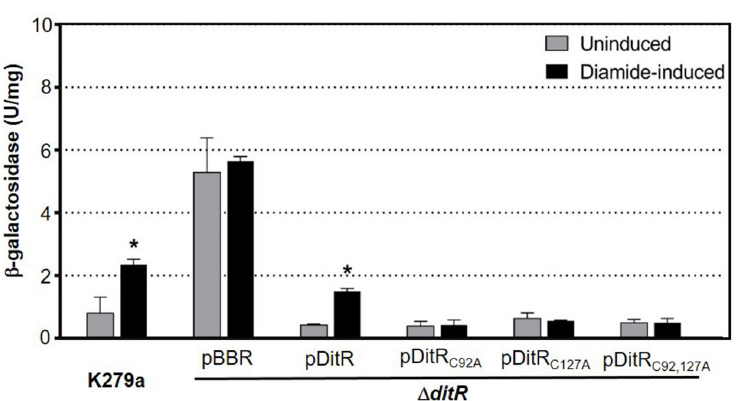
Fig 5. mfsBC promoter activity in S . maltophilia strains. The plasmid pP mfsBC -lacZ containing mfsBC promoter- lacZ fusion was introduced into S . maltophilia K279a and Δ ditR mutant, which harbored the pBBR1MCS vector ( Δ ditR / pBBR), pDitR ( Δ ditR /pDitR), pDitR C92A ( Δ ditR /pDitR C92A ), pDitR C127A ( Δ ditR /pDitR C127A ), or pDitR C92,127A ( Δ ditR / pDitR C92,127A ). Each strain was cultivated to an exponential phase before being induced with 500 μ M diamide. The β - galactosidase activity in the clear lysates was determined. Experiments were performed in triplicate, and data are presented as mean ± SD. Asterisk ( � ) indicates significant differences of the diamide-induced versus uninduced (UN) condition in each strain using a paired t -test (p-value < 0.05).